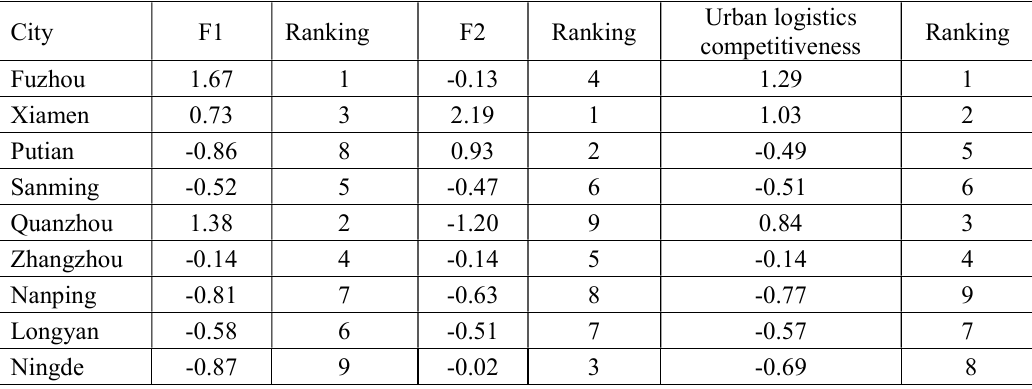
Table 3-4 Urban logistics competitiveness and